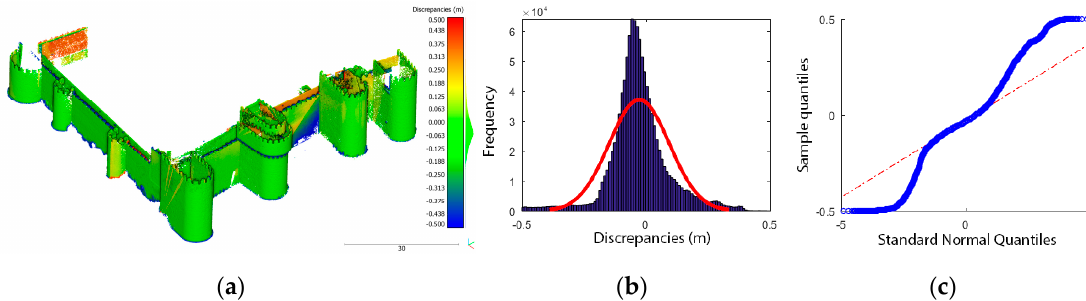
Figure 12. Reconstruction assessment of current remains: ( a ) spatial view of the signed discrepancies in the Alcázar gate and its surroundings; ( b ) histograms of the signed discrepancies with the superimposed curve for the normal distribution; ( c ) Q–Q plot of the distribution of the signed discrepancies. Adapted from [1].